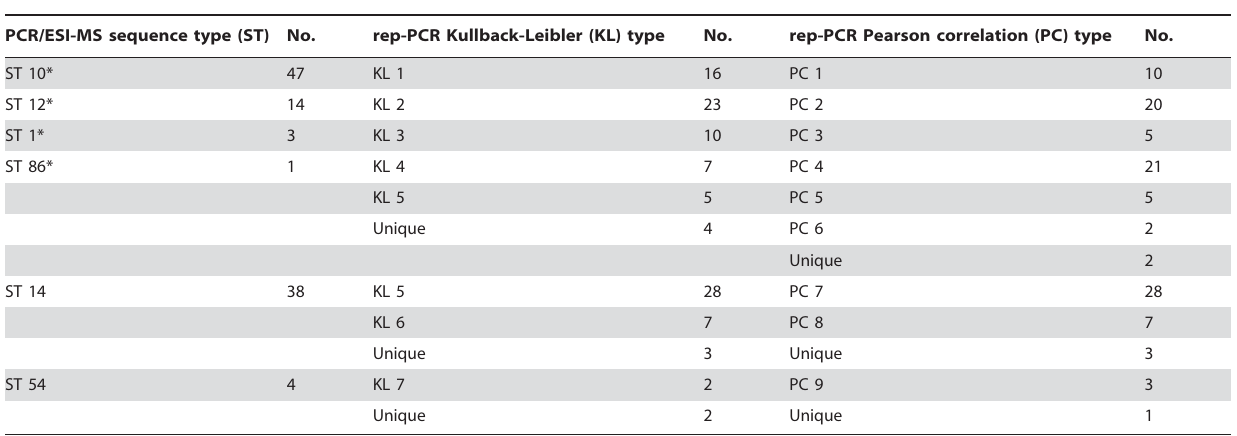
Table 1. Predominant PCR/ESI-MS sequence types and rep-PCR types analyzed by Kullback-Leibler (KL) and Pearson correlation (PC)